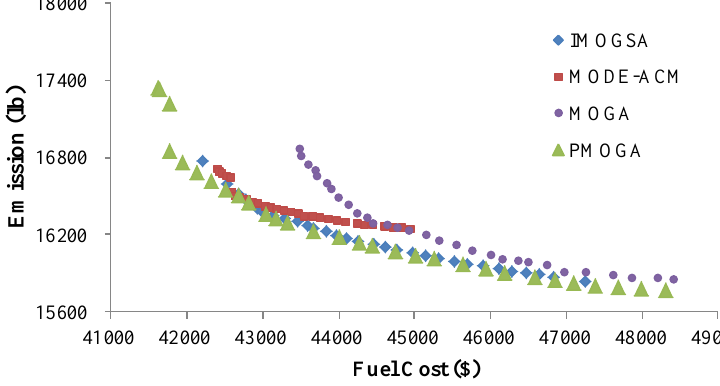
Figure 9. The optimal Pareto front by different algorithms for Case 2.